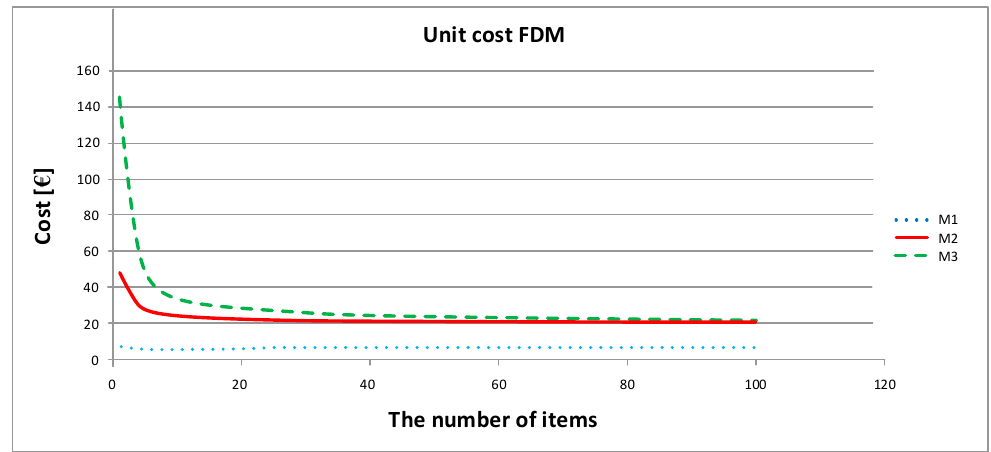
Figure 12. Dependence of the costs of bracket production on the number of prototypes for PJM technology.